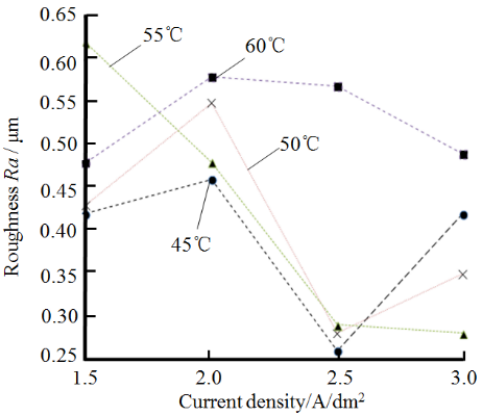
Figure 10. Effect of current density and bath temperature on the surface roughness Ra of the plated layer. From the samples tested above, five representative specimens are selected for X-ray diffraction testing based on the hardness and elastic modulus of the plating. The effect of the plating process parameters on the selective orientation, residual stress, and grain size of the nickel-plated layers is analyzed. The XRD diffraction pattern of a representative five specimens is shown in Figure 11. According to Figure 11, the diffraction peaks of X-rays appear along the crystal faces (111), (200), and (220) during the testing of five selected representative specimens. From the bottom up, the diffraction peaks on each crystal plane become wider, indicating that the grain size of the coating becomes smaller; from the top downwards, the diffraction peaks on the crystalline plane (200) of the nickel plating gradually